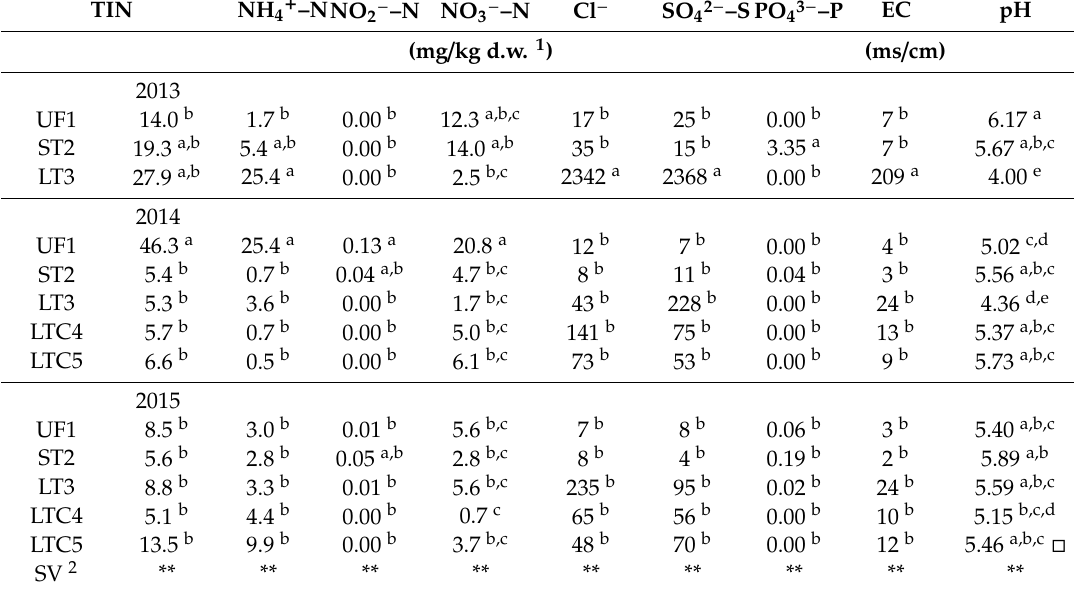
Table 2. Chemical characteristics of the soil